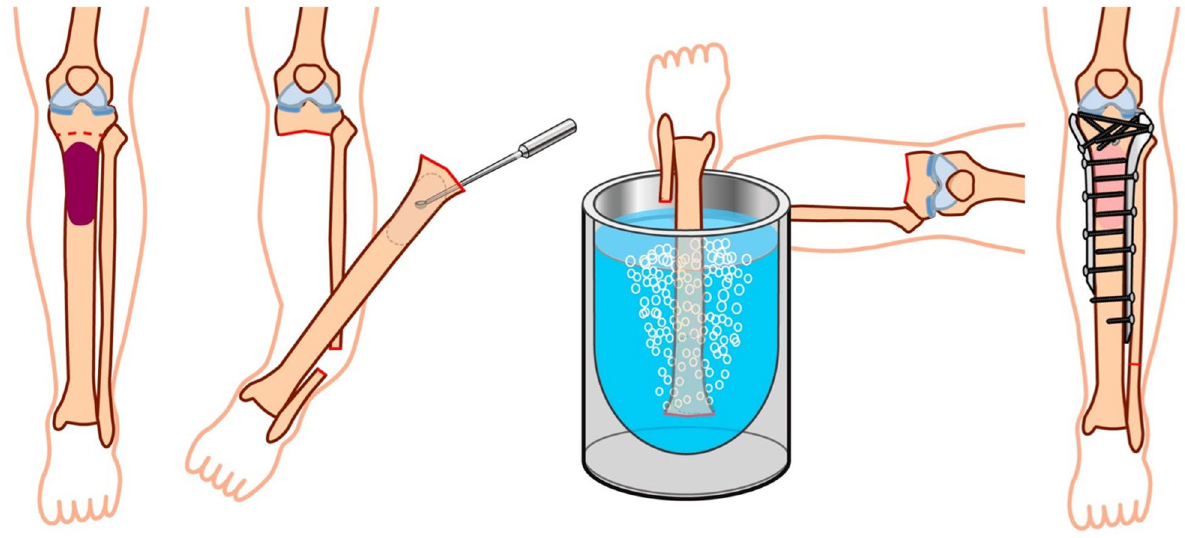
Figure 5. Pedicle freezing procedure. The bone tumor is excised with a pedicle to the healthy bone with an adequate margin. After curettage inside the tumor-bearing bone and removal of the surrounding soft tissue, the remaining bone was turned upside down, and then immersed and frozen for 20 min in liquid nitrogen. After thawing, the devitalized bone was fixed to the residual healthy bone on the original site with double locking